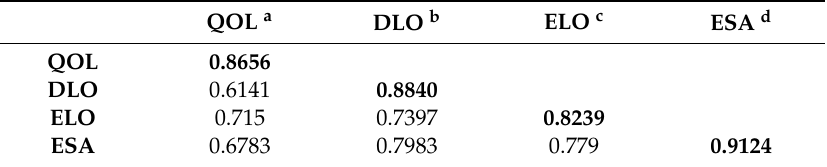
Table 7. Discriminant validity assessment